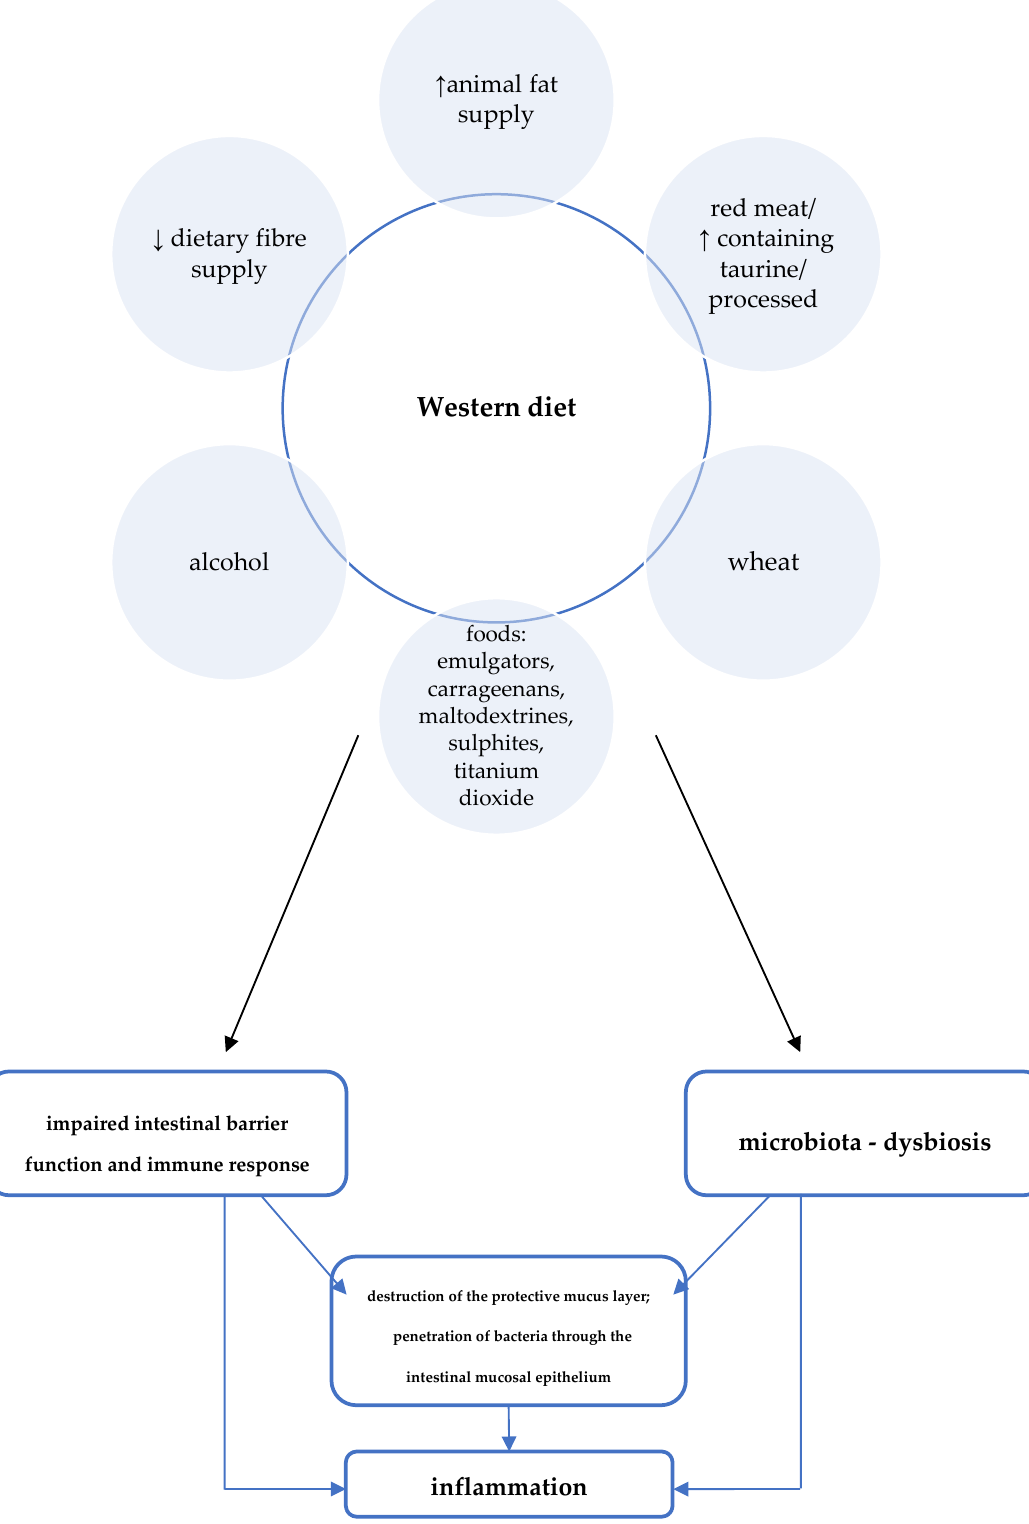
Figure 2. Western diet and the pathogenesis of Crohn’s disease [6].